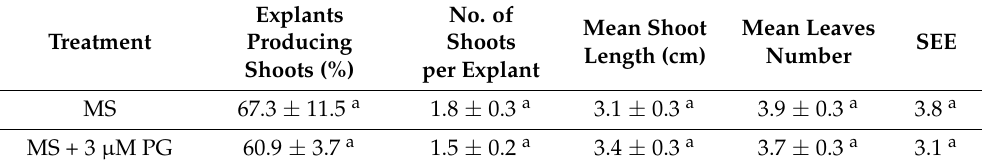
Table 1. Effect of different culture conditions on axillary bud formation in C. maritima explants.